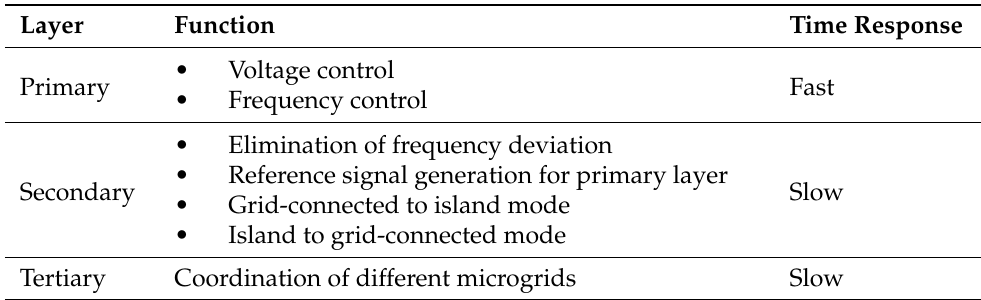
Table 6. Hierarchical control layer functions and their response